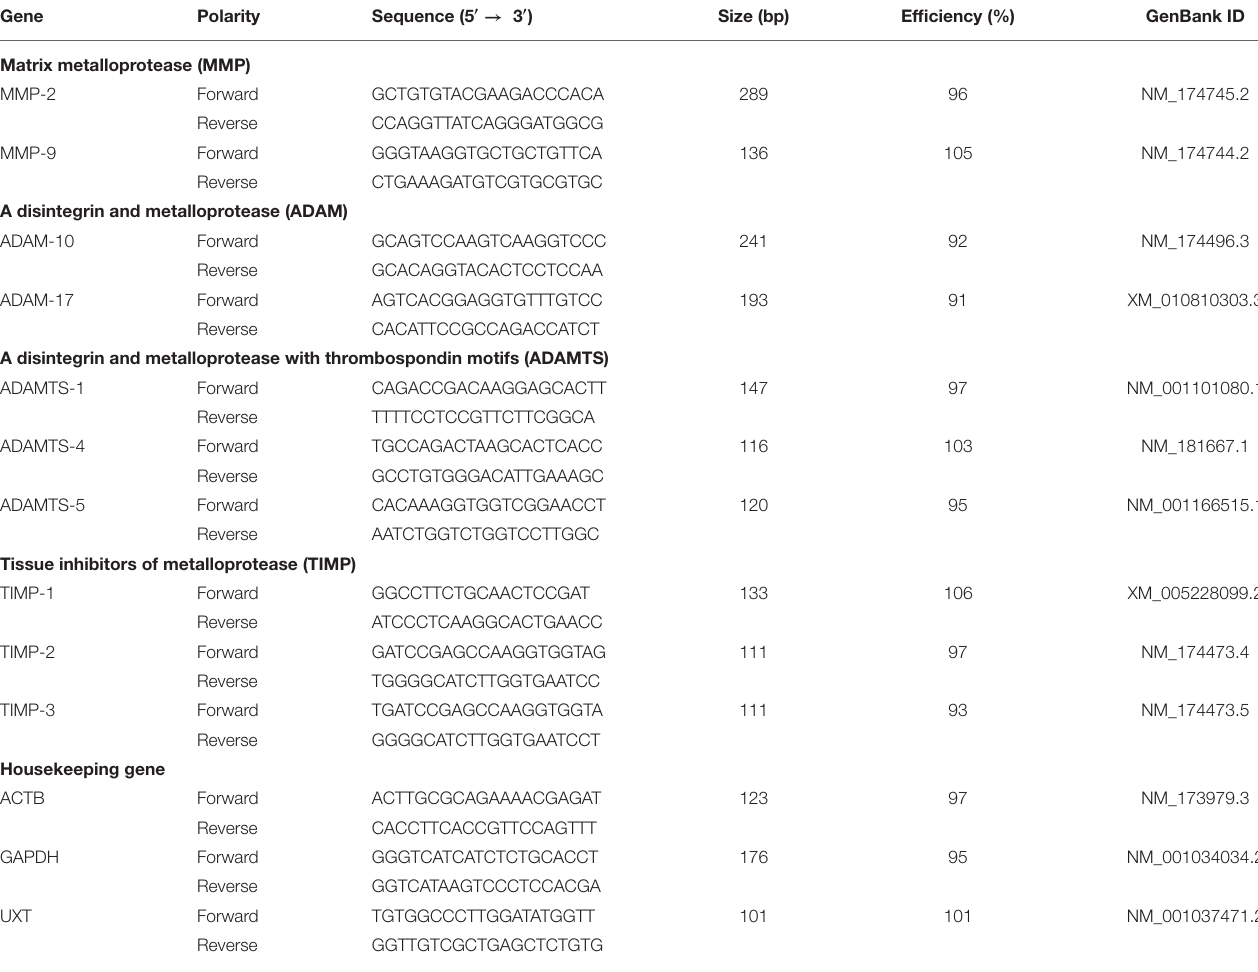
TABLE 2 | Gene, sequence, amplification size, and efficiency of the primers used for RT-qPCR. Gene Polarity Sequence (5 ′ → 3 ′